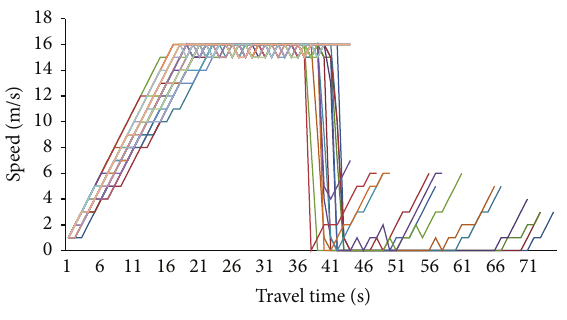
Figure 3: Speed contour profile in a signal cycle.